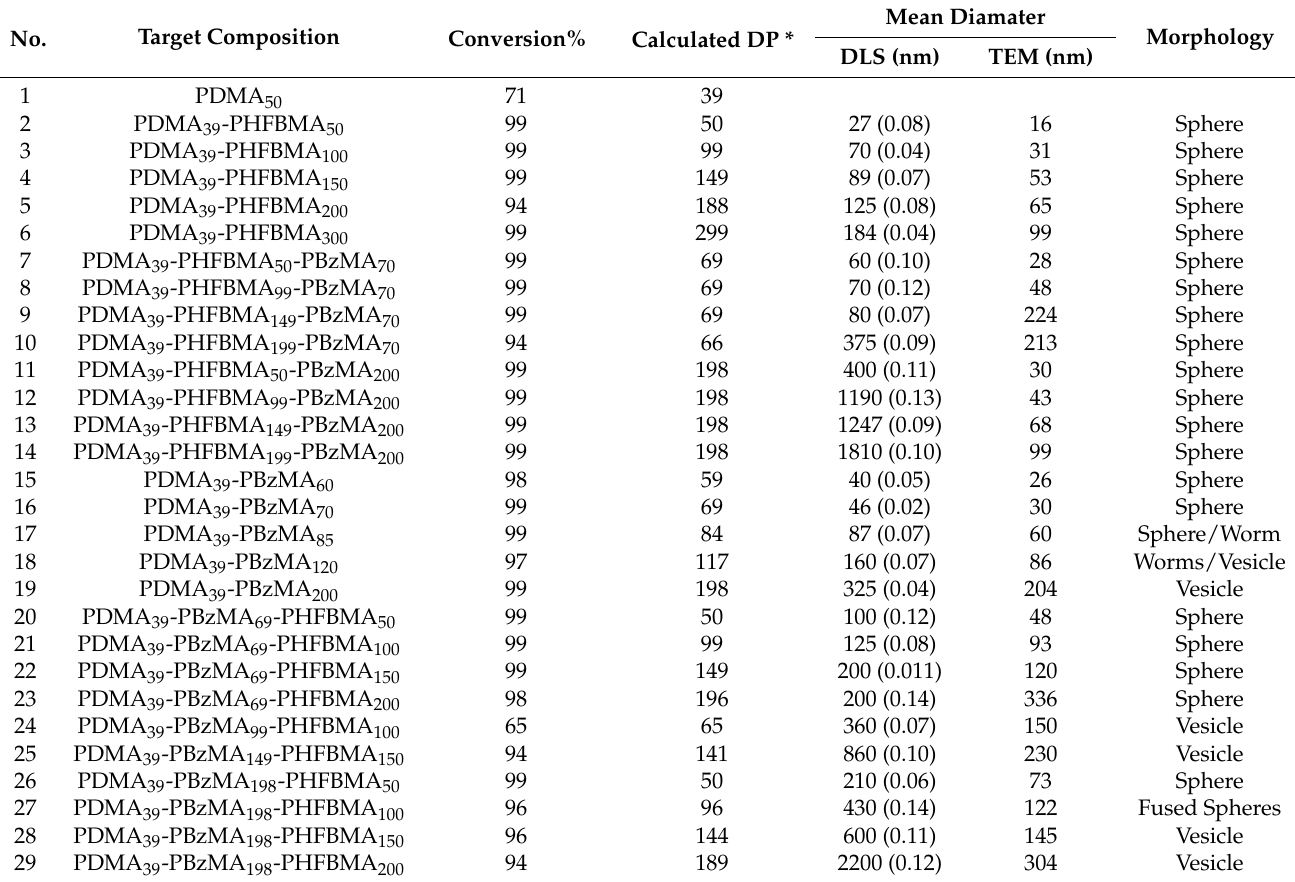
Figure 2. Evolution of number-average molar mass ( M n , black squares) and dispersity ( Ð , red open circles) with conversion for the RAFT dispersion polymerization of HFBMA at 10% w / w solids in ethanol at 70 °C using a PDMA 39 macro-CTA with macro-CTA/AIBN molar ratio of 5/1. The targeted diblock composition was PDMA 39 –PHFBMA 200 . Table 1. Summary of di- and triblock copolymers characterizations.